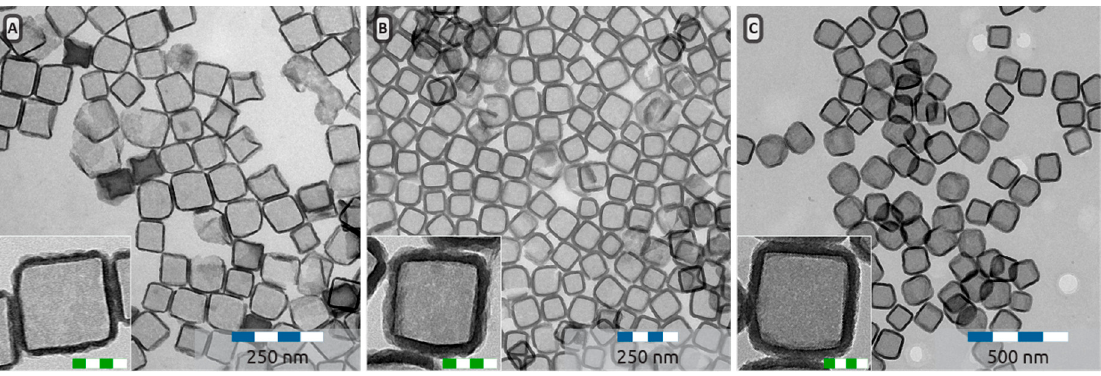
Figure 9. Hollow silica nanocubes with a silica shell of 5.1 ± 0.6 nm (8-A), 12.6 ± 1.6 nm (8-B) and 16.4 ± 1.9 nm (8-C) thick. Insets are higher magnification micrographs. Scale bars in the insets are 50 nm.